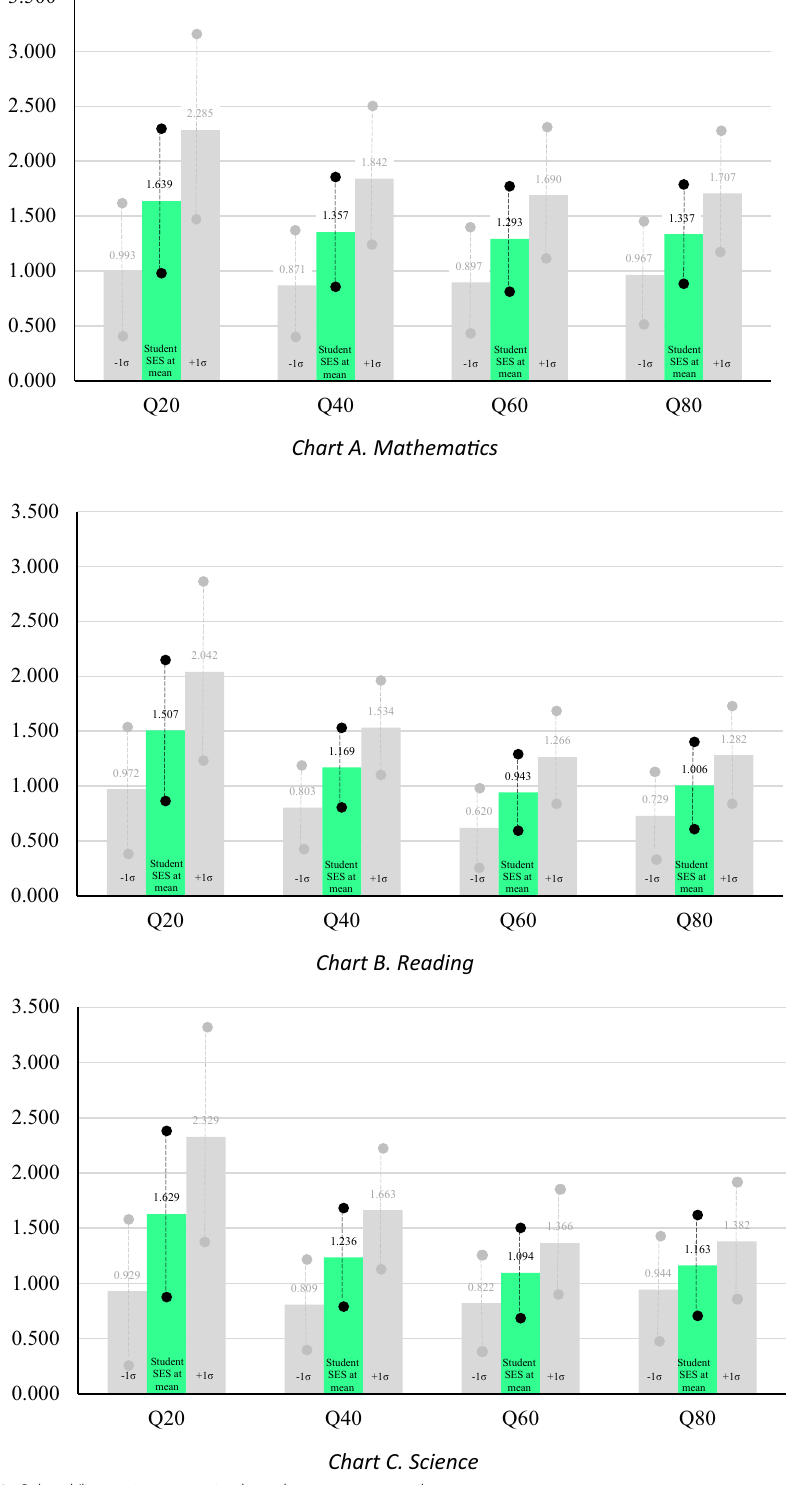
Fig. 3 School/home impact ratios by achievement